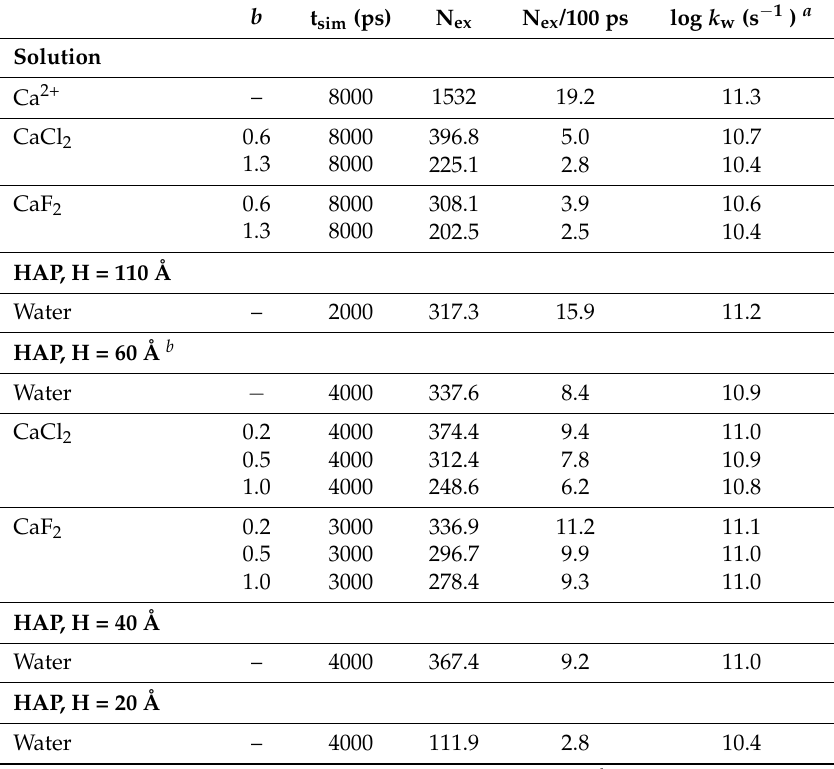
Table 4. Number of accounted water exchange events (N ex ) in the coordination shell of the calcium ions with a duration of more than 0.5 ps. For the HAP-solution systems, the values of N ex have been normalized with respect to the number of calcium atoms at the surface. Concentration ( b ) in mol · kg − 1 . b t sim (ps) N ex N ex /100 ps log k w (s − 1 ) a